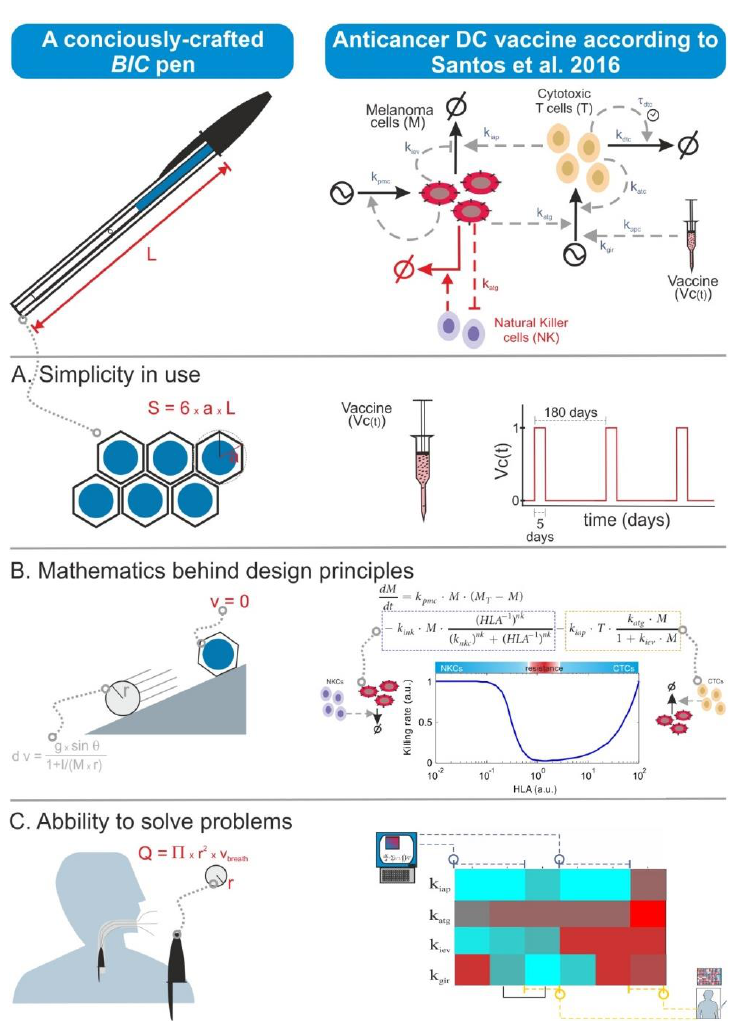
Figure 4. BIC pen-like mathematical models: prioritizing the purpose of the model instead of its detailedness. BIC pens look like the simplest and cheapest ballpoint pen one can buy, but their apparent simplicity conceals features conceived to optimize them in economic, ergonomic, and safety terms. In Santos and coworkers 2016 [3], a similar strategy was followed to build a mathematical model accounting for anticancer dendritic cell (DC) vaccination composed of only two ordinary differential equations, far simpler than other published models [41]. ( A ) Simplicity in design: BIC pens have a characteristically simple hexagonal structure; this apparently naïve choice significantly reduces the material consumption of the pen and minimizes the required space for storage. An important aspect to consider in DC vaccine modelling is the bioavailability of the cells after their injection. There are much elaborated models describing this process [42], but for our purpose, it was sufficient to model DC bioavailability with a cyclic piecewise linear function that mimics the known overall behavior of injected DCs. ( B ) Mathematics behind design principles: compared to standard circular pens, BIC pens hardly roll on the surface of a table. This feature was explicitly desired when drafting their design. In Santos et al., we wanted a simple enough model that was still able to mimic the interaction between the tumor and both innate and adaptive immunity; to this end, the model contained two nonlinear kinetic rates in a single equation, which are still able to mimic the basics of the interplay between the tumor and the two branches of immunity. ( C ) Ability to solve problems: in the end, simplicity has to be reconciled with effectiveness. The design of a BIC pen, for example, integrates more characteristics like minimizing the risk of suffocation when swallowing the cap. The predictions made in Santos et al. (2016) in terms of which phenotypic features sensitize the tumor to the therapy were aligned with patient data from clinical trials; furthermore, the model predicted alternative phenotypes that promote therapy resistance. The figures about DC vaccine modelling are adapted from Santos et al. 2016 under the conditions of an open access publication (CC BY 4.0). The figures about the BIC pen were inspired by the content of the webpage www.bicworld.com. Fight by doing: A route map to good mathematical modelling in biomedicine.